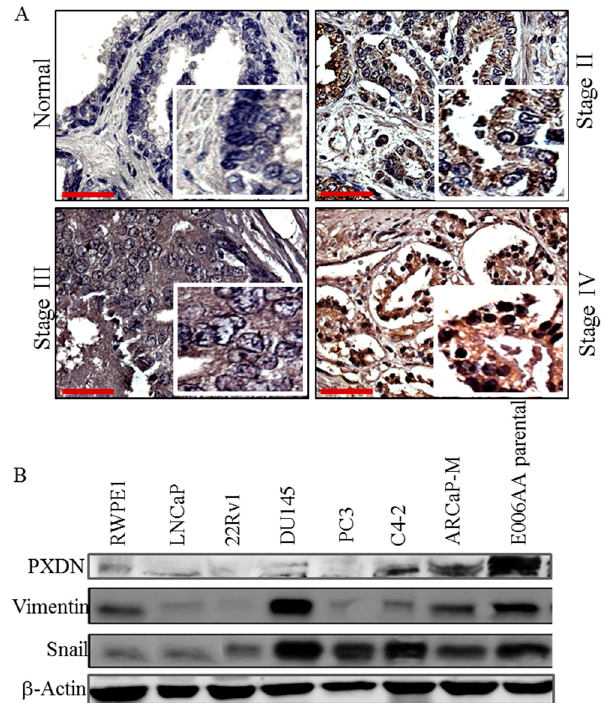
Figure 1. PXDN expression increases with prostate cancer progression. ( A ) Immunohistochemical (IHC) analysis was performed using a 96-core prostate adenocarcinoma tissue microarray. Representative images of PXDN in various stages of prostate cancer show that PXDN increases with tumor progression. Bar represents 50 µ M. ( B ) Western blot analysis was performed on RWPE1 normal transformed epithelial cell line and various prostate cancer cell lines with antibody against PXDN or mesenchymal markers Snail and vimentin. Actin was utilized as a loading control. Data are representative of at least 3 independent experiments.